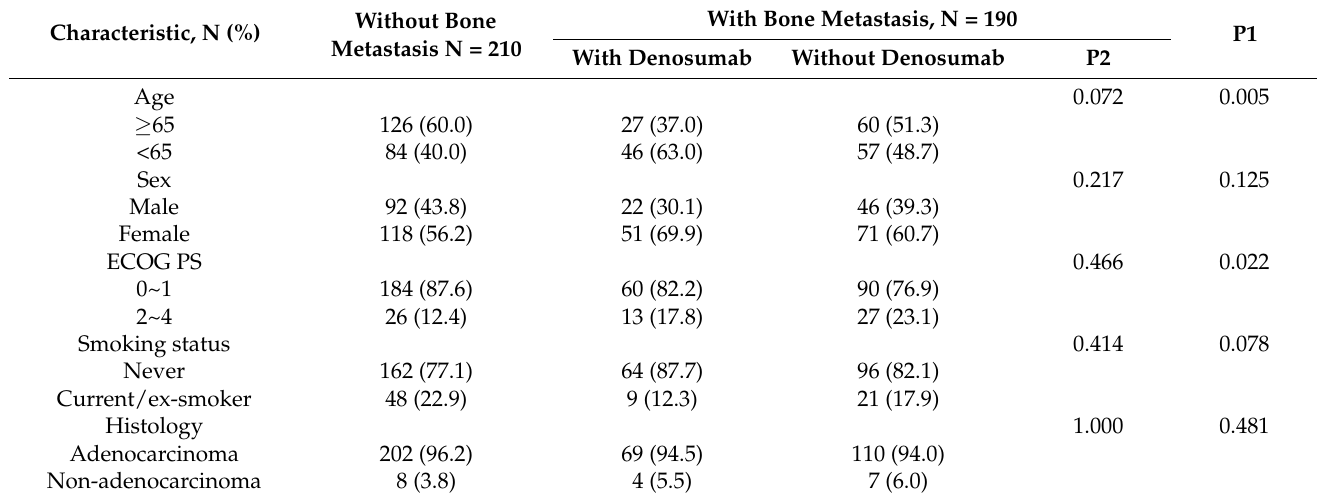
Table 1. Baseline Characteristics of all metastatic EGFR -mutant NSCLC